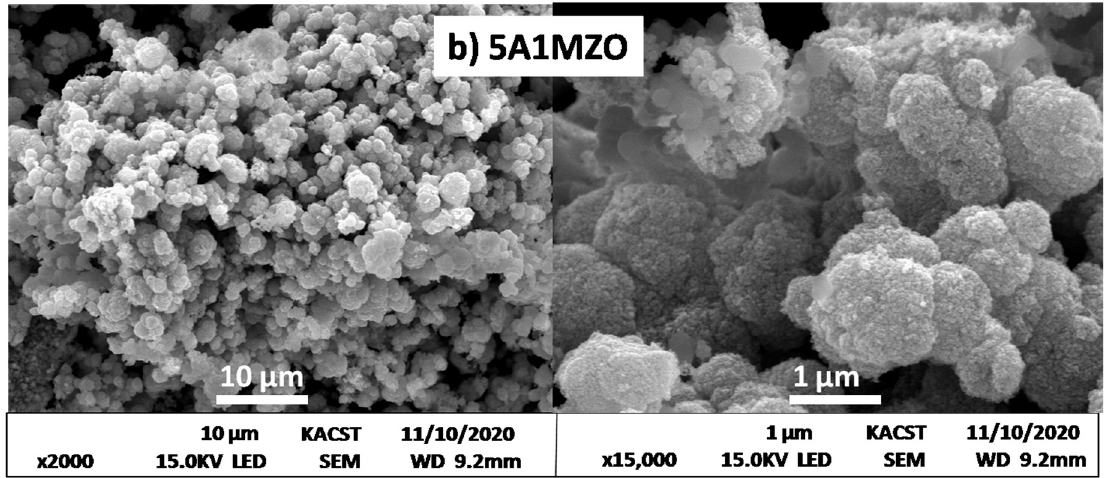
Figure 5. FESEM images of ( a ) 1MZO and ( b ) 5A1MZO at different magnifications.